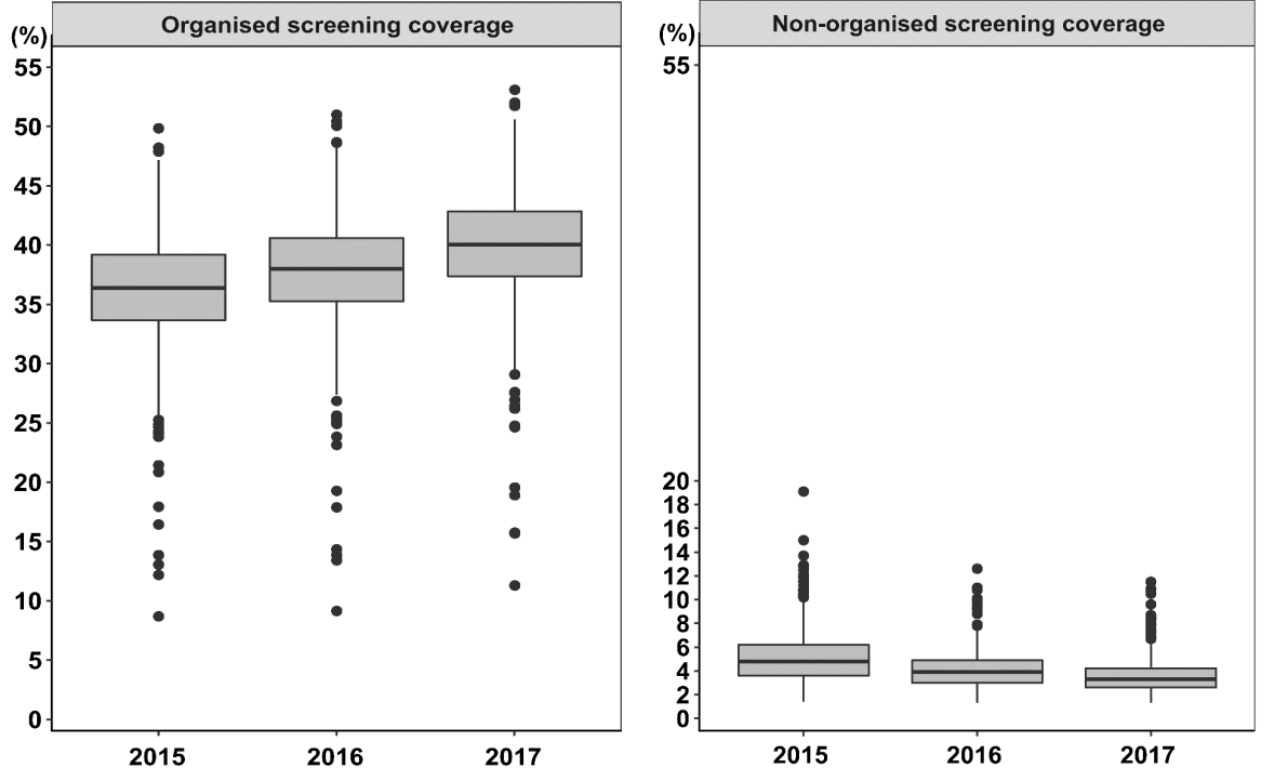
Figure 2. Organised and non-organised faecal occult blood test screening coverage of 308 municipalities in Flanders, 2015–2017. The outlier points show that there are a number of municipalities with extremely low organised screening coverage (below 1.5 times the interquartile range) and municipalities with extremely high non-organised screening coverage (above 1.5 times the interquartile range).